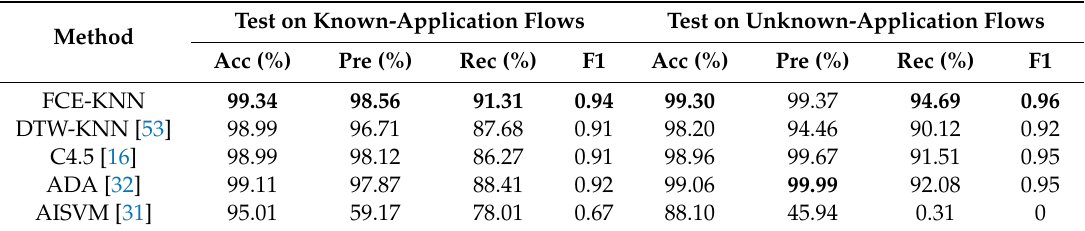
Table 3. Performance comparison between FCE-KNN and other algorithms for identifying the encryption status of network